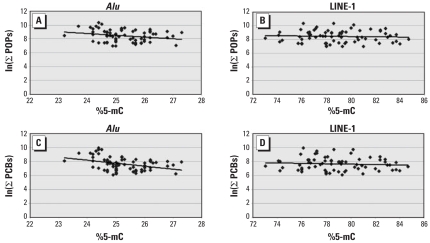
Linear plots of %5-mC, based on Alu and LINE-1, versus the natural log of ∑POPs and ∑PCBs. (A) Alu versus ln(∑POPs). (B) LINE-1 versus ln(∑POPs). (C) Alu versus ln(∑PCBs). (D) LINE-1 versus ln(∑PCBs).